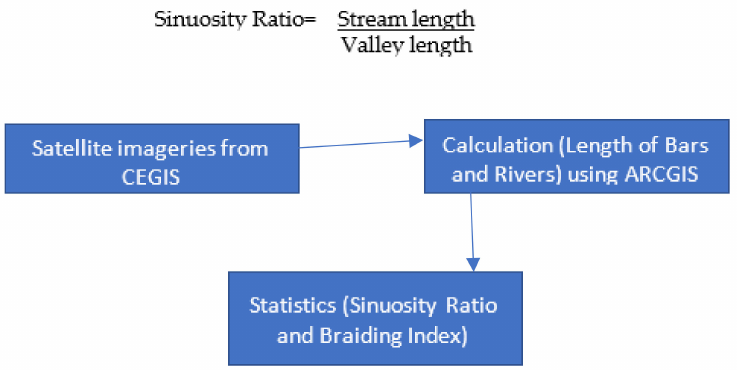
Figure 3. A flowchart of the